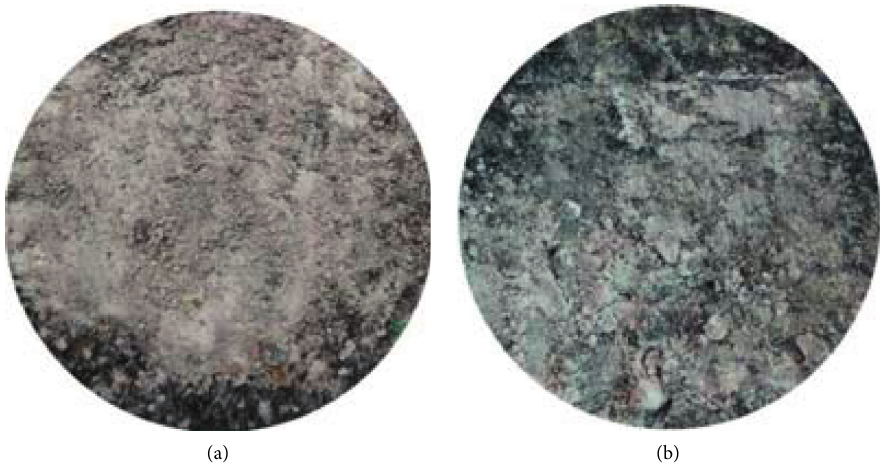
Figure 11: Under direct shear stress. (a) Upper fracture surface. (b) Lower fracture surface.